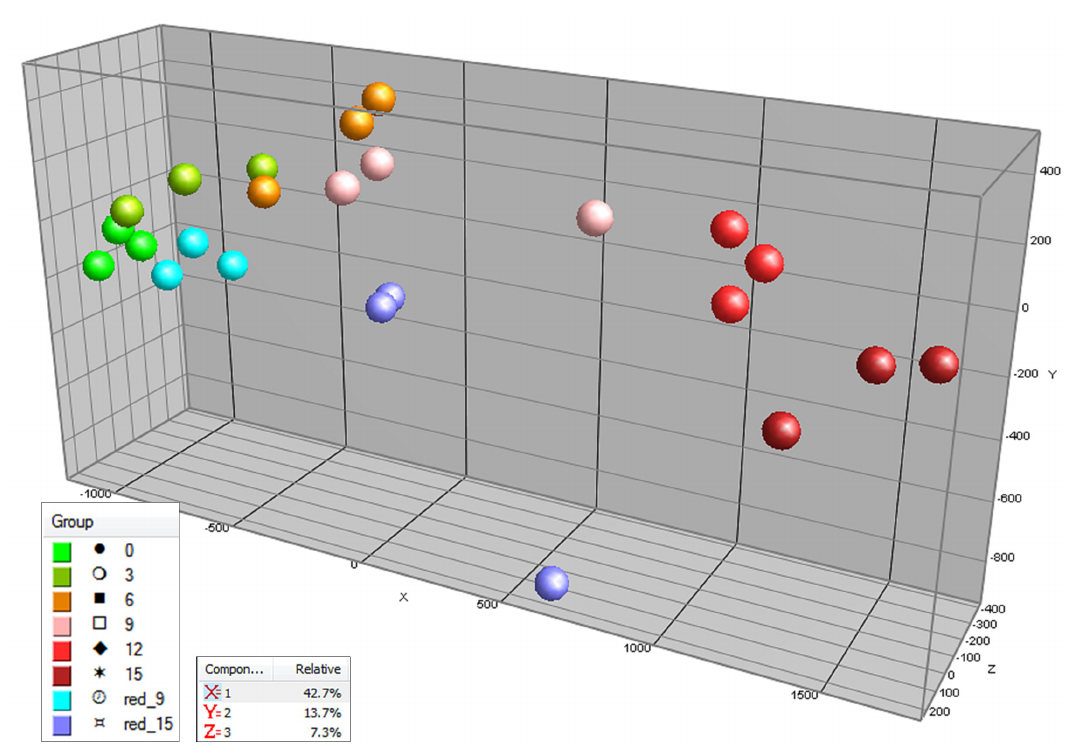
Figure 2. Principal component analysis (PCA) of tomato samples from experiment 1, based on their variations in relative abundance of 437 mainly secondary metabolites detected by LCMS based untargeted metabolomics. The fruits were treated with either light (500 μmol m −2 s −1 ) or darkness for 15 days. Samples of the light treatment were measured every three days and for the dark treatment at 9 and 15 days after the beginning of the experiment (t = 0 days). PC1 = X -axis = 42.7% explained variation; PC2 = Y -axis = 13.7% explained variation; PC3 = Z -axis = 7.3% explained variation. (Light treatment: t = 0 days—light green points, t = 3 days—dark green points, t = 6 days—orange points, t = 9 days—pink points, t = 12 days—light red points, t = 15 days—dark red points. Dark treatment: t = 0 days—light green points, t = 9 days—light blue points, t = 15 days—purple points.)